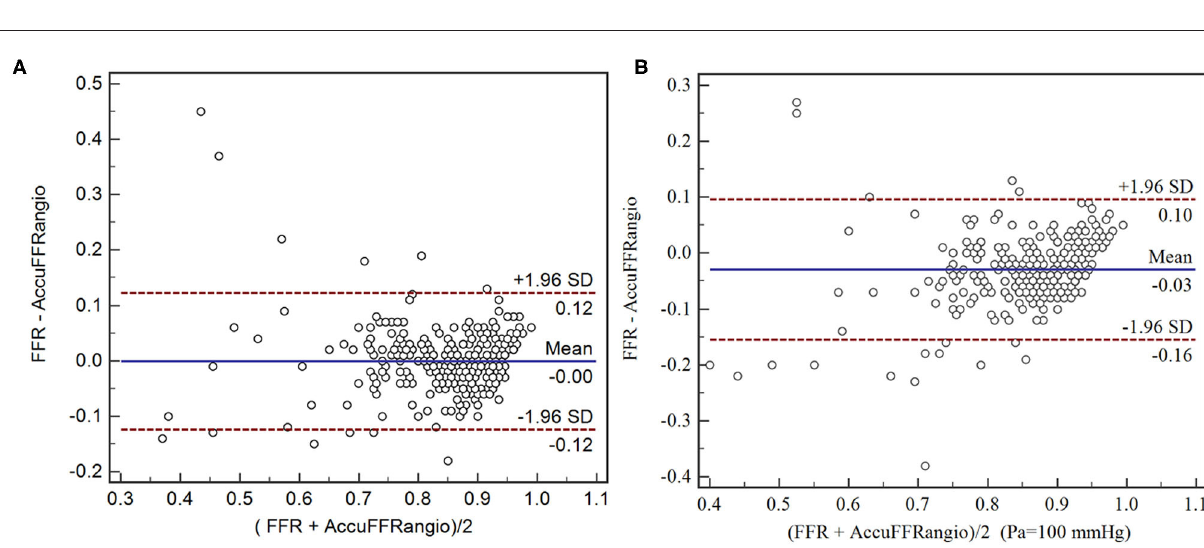
FIGURE 5 | Agreement between AccuFFRangio computation and conventional pressure wired measured FFR. (A) Pa from the measurement of the pressure at the coronary ostium; (B) Pa set as equal to 100